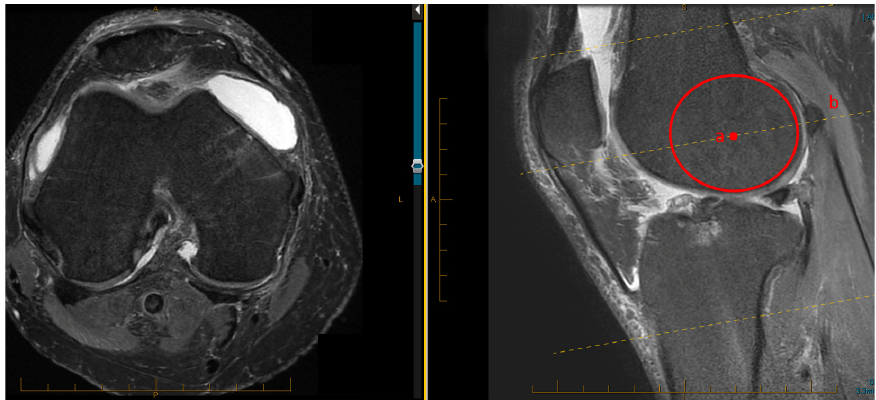
Figure 1. Technique for measuring the rotation of the femoral component based on MRI images: in a split ‐ screen mode, with the cross ‐ reference line tool (dotted yellow lines) activated, sagittal ( right ) and axial ( left ) images were selected. The sagittal image which showed the largest diameter of the lateral femoral condyle was selected. A best ‐ fit circle tool was used to identify the position of the epicondyle (point a, red circle). The corresponding cross ‐ sectional axial image (dotted yellow line, b) was selected in the adjacent screen. All measurements were performed on this screen.